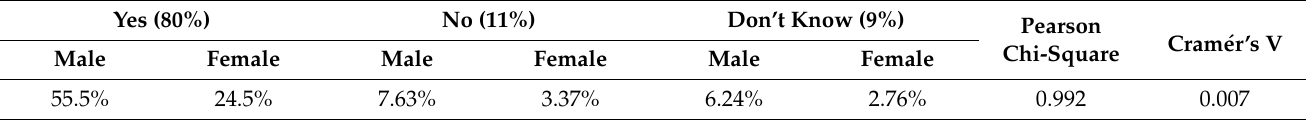
Table 13. refer back to Figure 4. Gender adaptation_measures_affect_differently_men_and_women